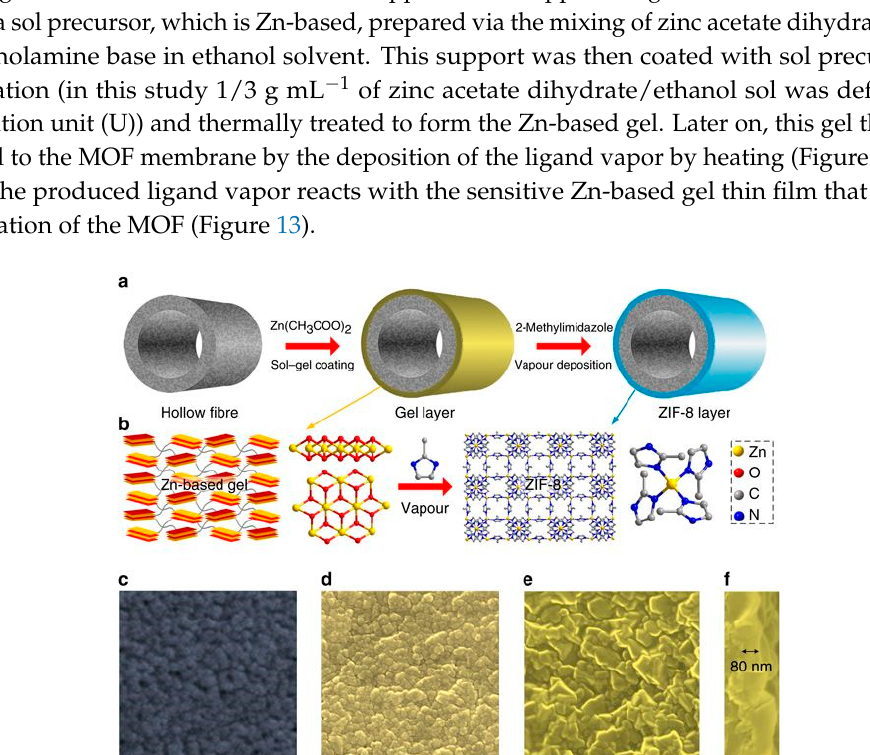
Figure 12. SEM surface images of ZIF-8/PTSC membranes prepared with different reactant concentrations: ( a ) M1, ( b ) M2, ( c ) M3, and ( d ) M4. Scale bar: 10 mm (adapted with permission from ref. [95]).